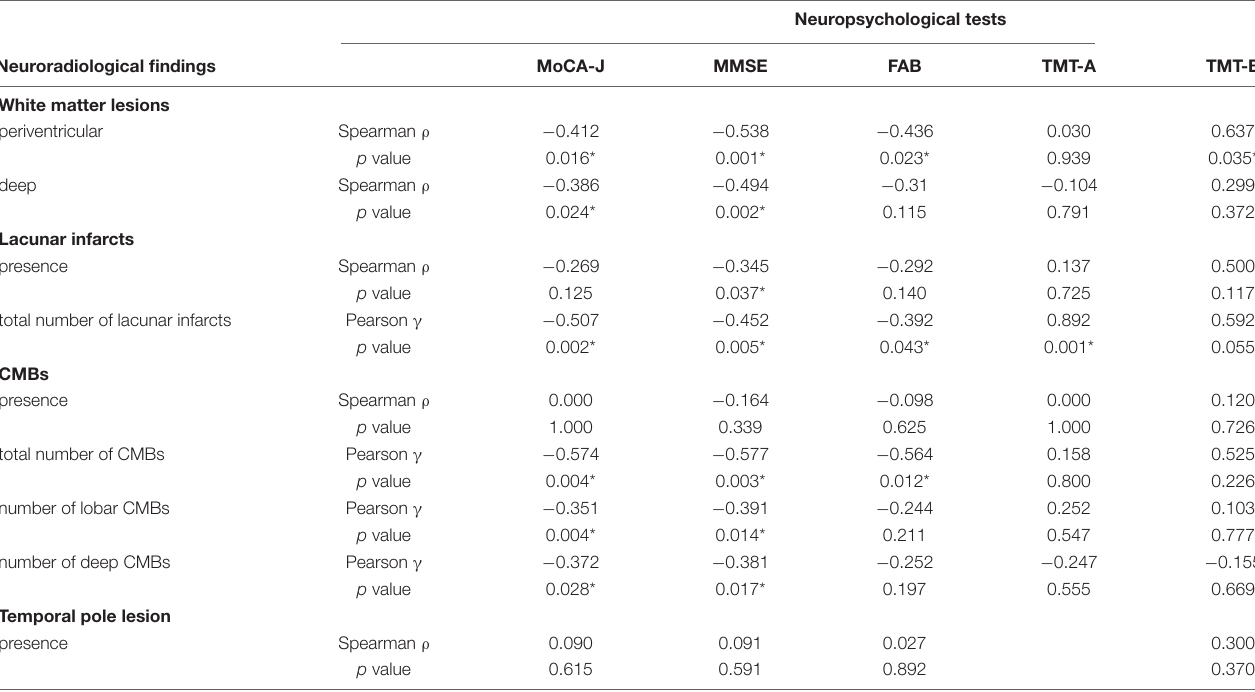
TABLE 3 | Correlations between neuropsychological tests and neuroradiological